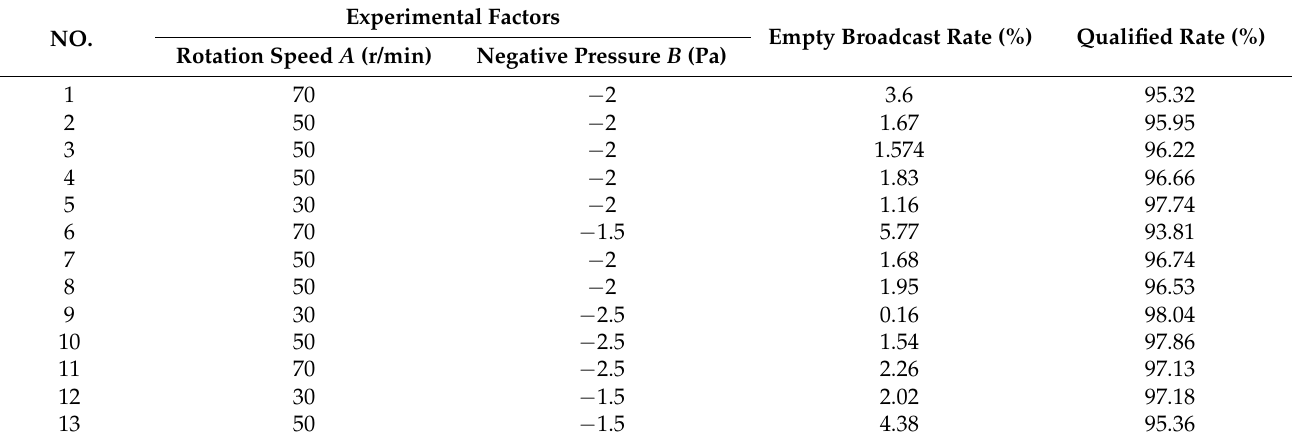
Table 3. The test results for the seed arrangement performance.